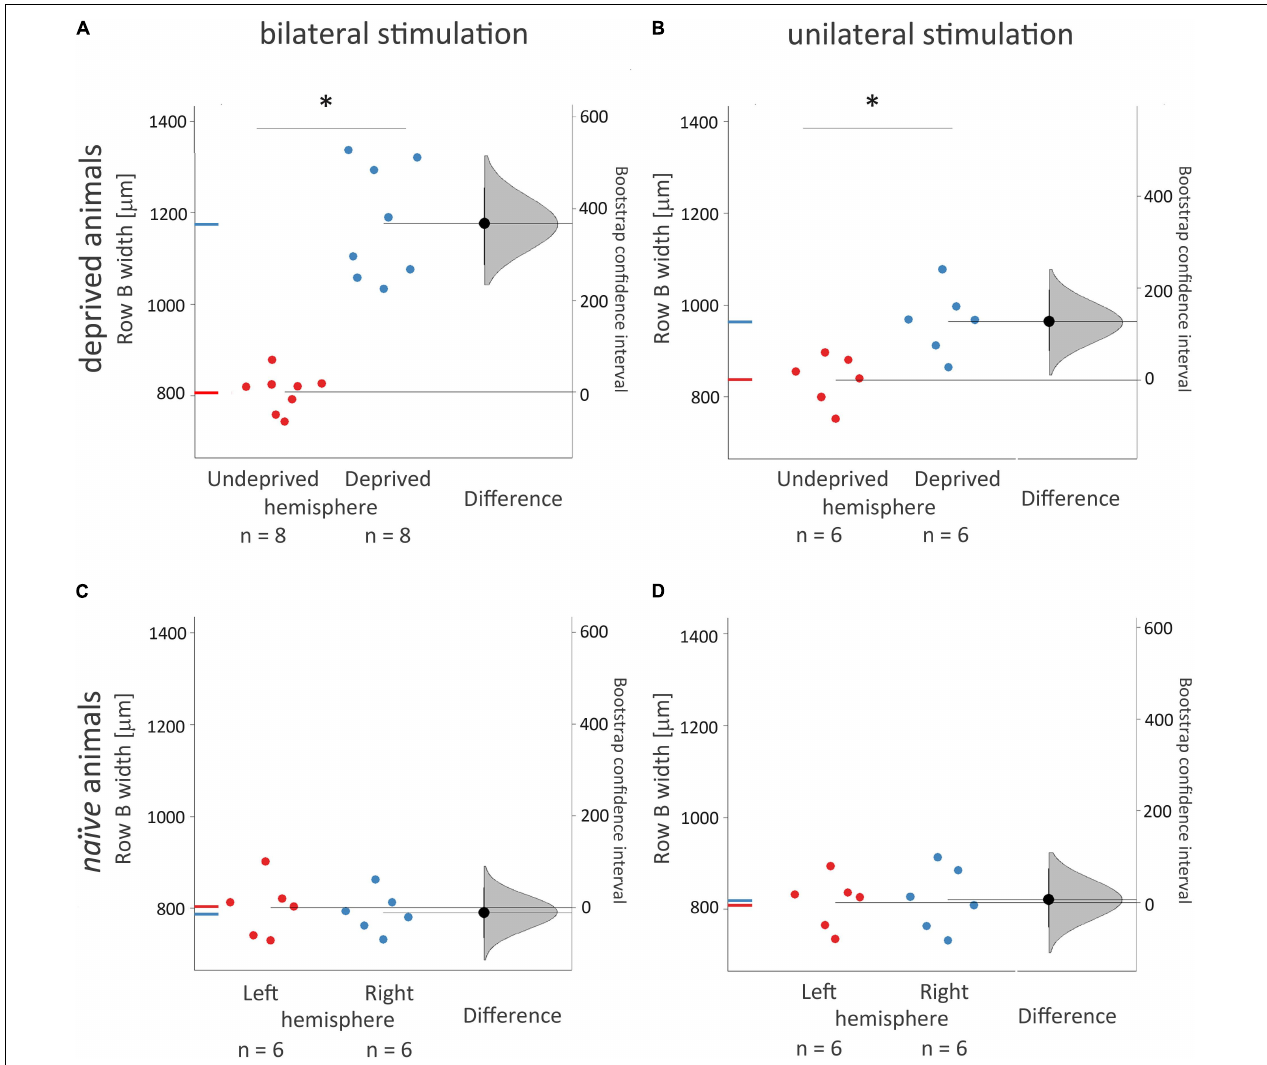
FIGURE 3 | Width of 2DG incorporation in rows B representations in the contralateral, deprived, and non-deprived hemispheres and its dependence on uni- vs. bilateral whiskers stimulation. Experimental groups were deprived and bilaterally ( A . n = 8) or unilaterally ( B . n = 6) stimulated during brain activity mapping; naïve rats ( C ., D. ) received just whiskers stimulation during brain activity mapping. ANOVA with post hoc Tuckey test and bootstrap analysis were used. The right curve shows an estimation plot emphasizing the effect size – the difference between the group means of the left and right hemispheres. The 0 point of the “difference axis” (on the right) is based on the mean of the reference group (the naive control group, presented below). The filled triangles show the difference between left and right hemispheres, with 95% confidence intervals. The curves illustrate the range of expected sampling error in estimating the mean difference. *Mean ± SD; * P <